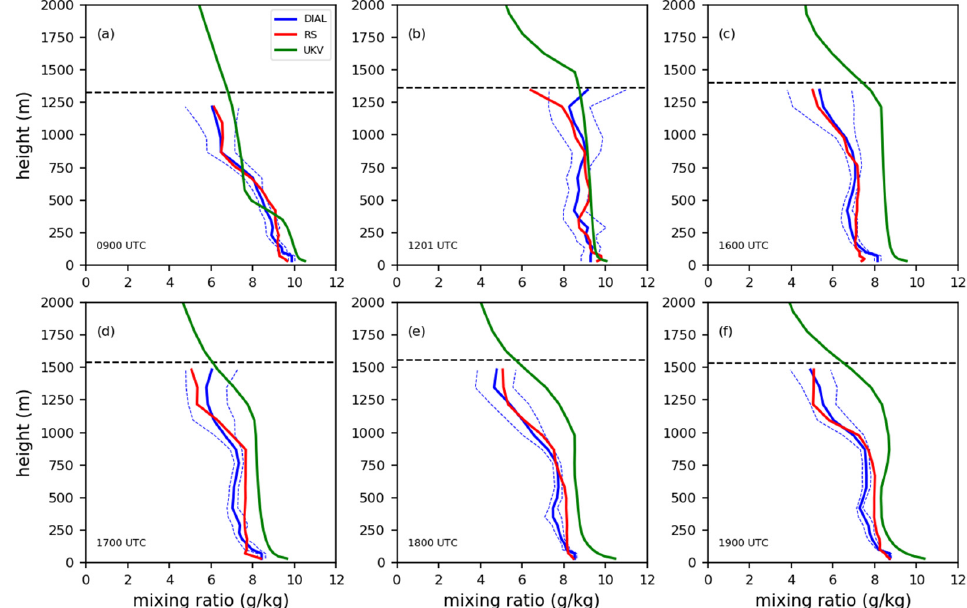
Figure 12. Water vapour mixing ratio profiles for different times on 24 June 2020: ( a ) 09:00 UTC, ( b ) 12:00 UTC, ( c ) 16:00 UTC, ( d ) 17:00 UTC, ( e ) 18:00 UTC, ( f ) 19:00 UTC. The horizontal dashed line represents the maximum height from the Vaisala algorithm.